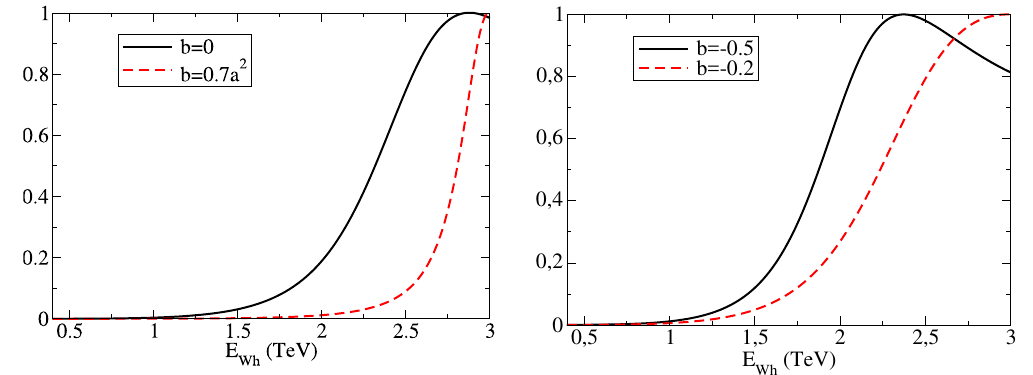
Figure 3 . The I = J = 1 axial resonance generated in V L h scattering. Here we show the dependence on b , with a fixed (on the left plot, to 0.95, on the right to -0.9) as well as fixing e (to 1.64 10 − 3 on the left plot, to 0 on the right). In both cases d = ×